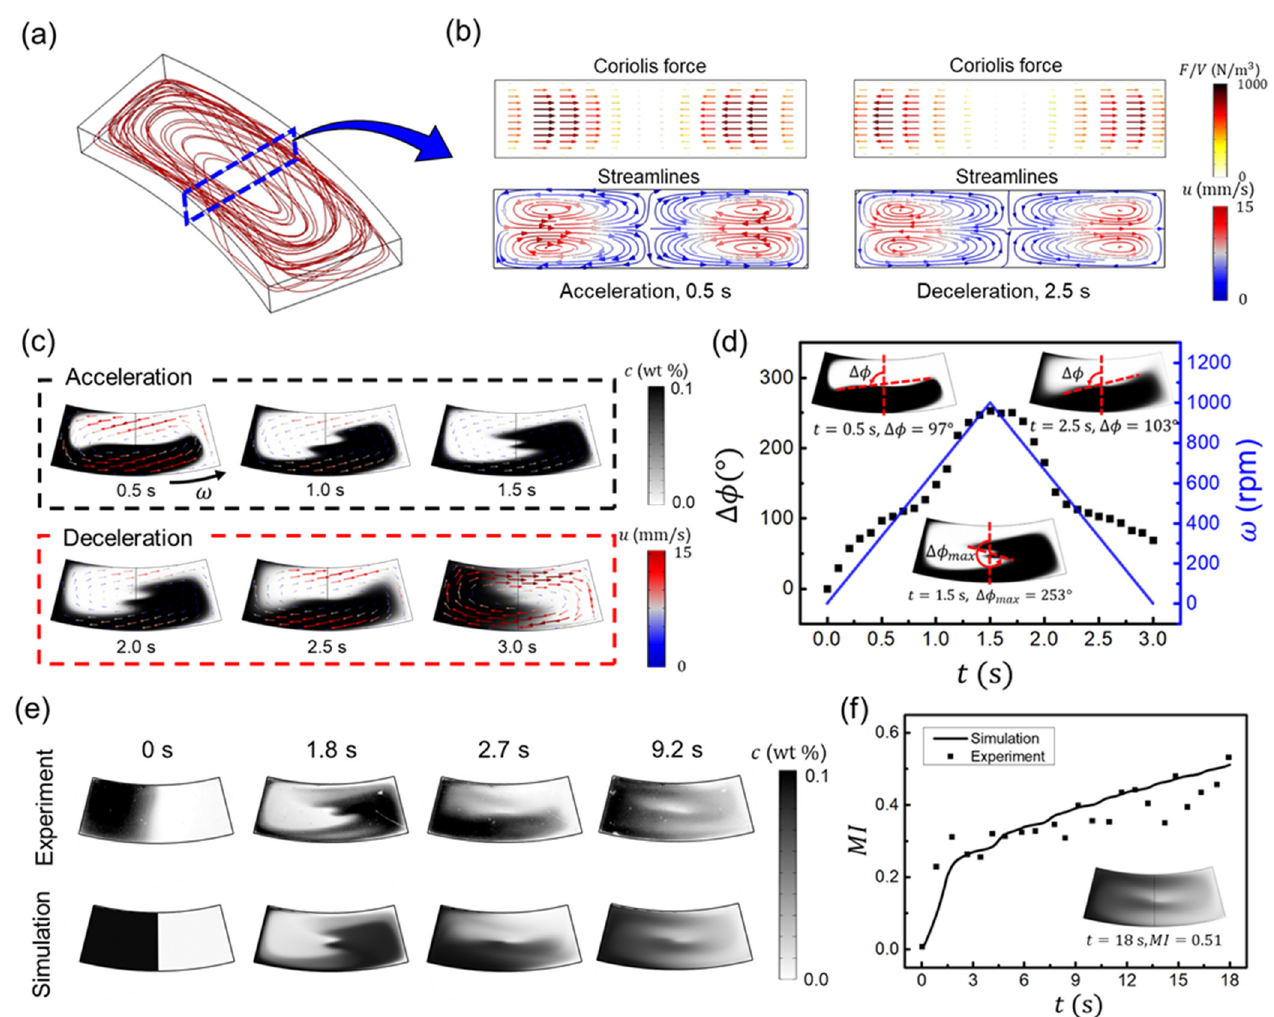
Figure 2. Simulation and experiment results when the rotational velocity ω was varied as a triangular waveform from 0 to 1000 rpm every 3 s. ( a ) Simulation result showing 3D streamlines in the chamber. ( b ) The Coriolis force and the streamlines at 0.5 s and 2.5 s at the cross-sectional mid- plane (blue dashed line in ( a )). ( c ) Concentration and velocity vectors at the horizontal mid-plane during acceleration and deceleration. ( d ) Angular displacement ( ∆ φ ) and rotational velocity ( ω ) with time. The term ∆ φ indicates the angle, measuring the angular displacement between the initial and leading interfaces of the solutions. ( e ) Comparison of mixing behaviors between the simulation and experiment. ( f ) Mixing index for simulation (solid line), experiment (dots), and the image of simulation at 18 s of mixing where MI = 0.51